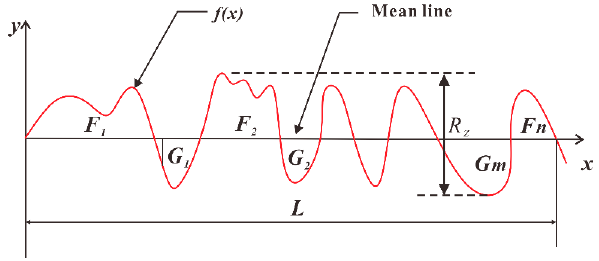
Figure 3. Definition of the parameters R a and R z .